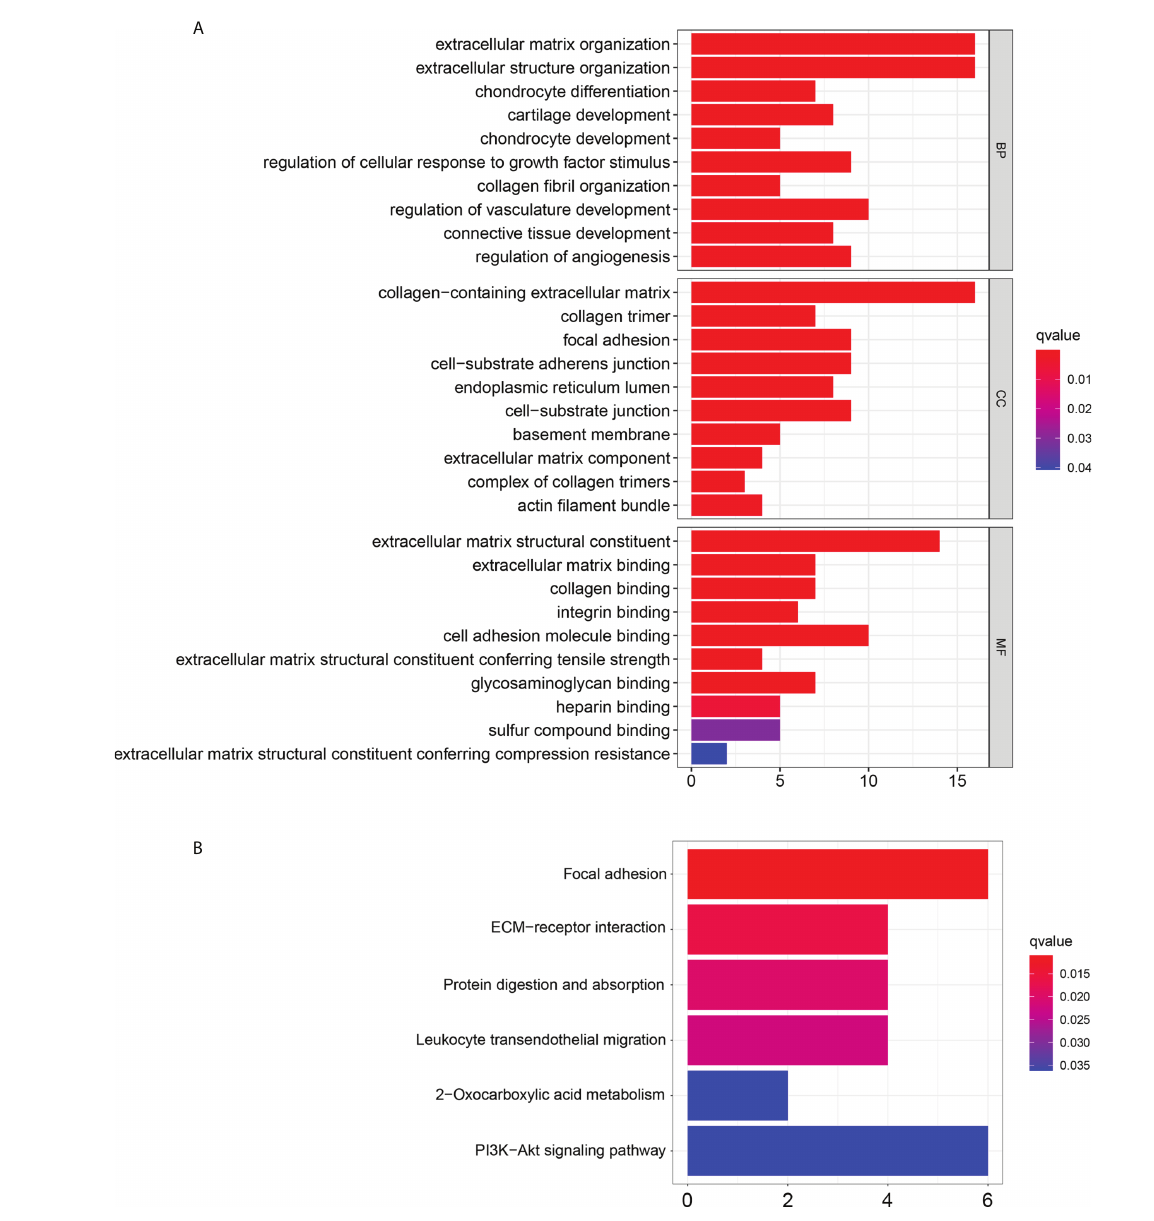
FIGURE 6 | GO and KEGG enrichment analysis of the genes in the red module. (A) GO enrichment analysis based on biological processes (BP), cellular compartments (CC), and molecular functions (MF). (B) KEGG enrichment strati fi ed into a high-expression group and a low-expression group based on the median value of each gene. As shown in Figure 9 , The survival of patients with high expression of TGFBI is better than those patients with low expression of TGFBI.